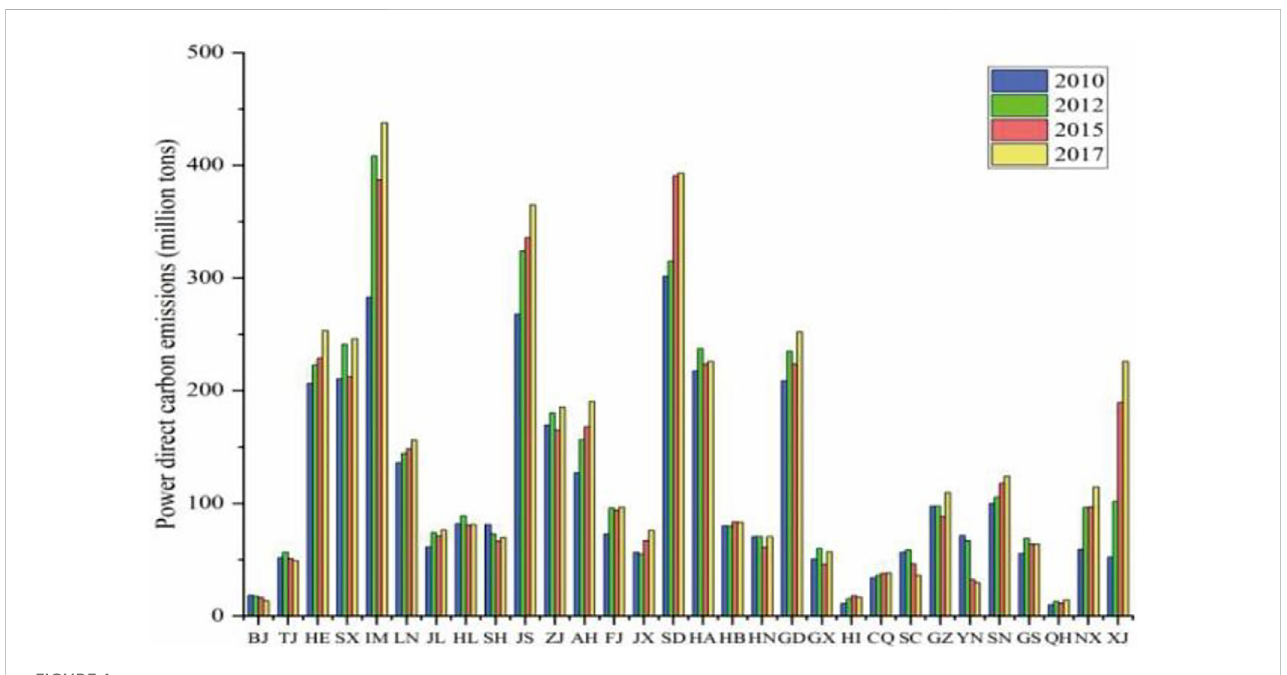
FIGURE 1 Direct carbon emissions from power sector in provinces of